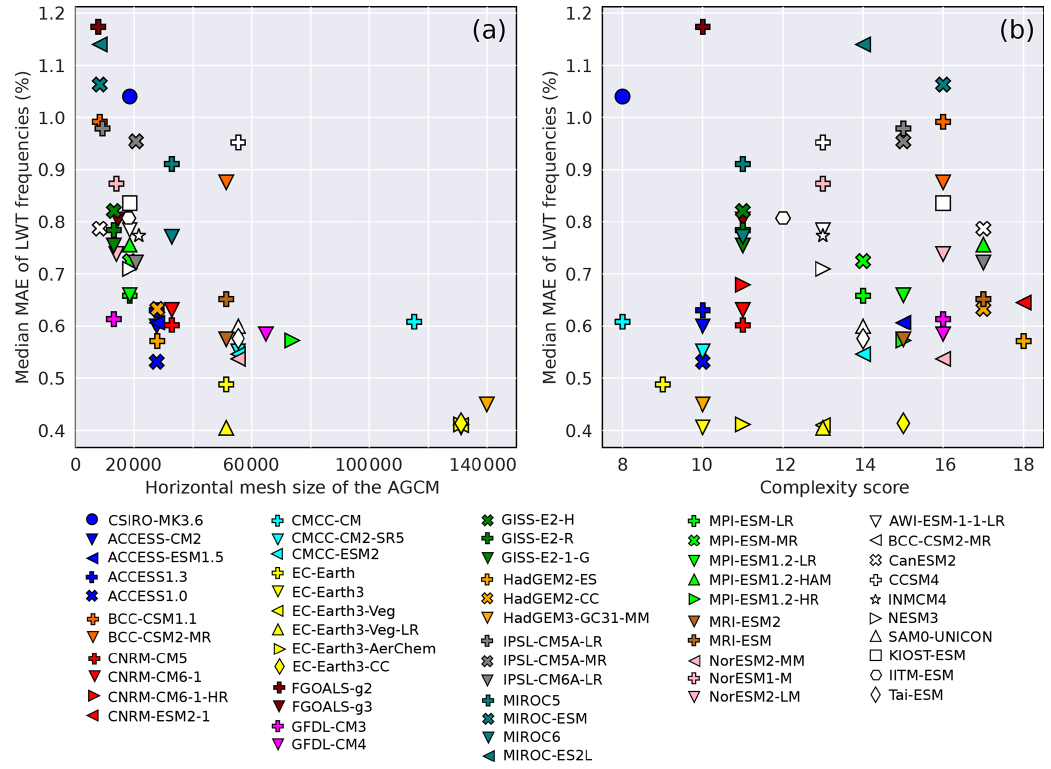
Figure 13. Relationship between the median performance of the coupled model configuration and (a) the horizontal mesh size of the atmo- spheric component or (b) the coupled model complexity score described in Sect. 3.3. Model performance is with respect to ERA-Interim. CNRM-CM6-1-HR and CNRM-ESM2-1 are out of scale in panel (a) due to their very fine atmospheric